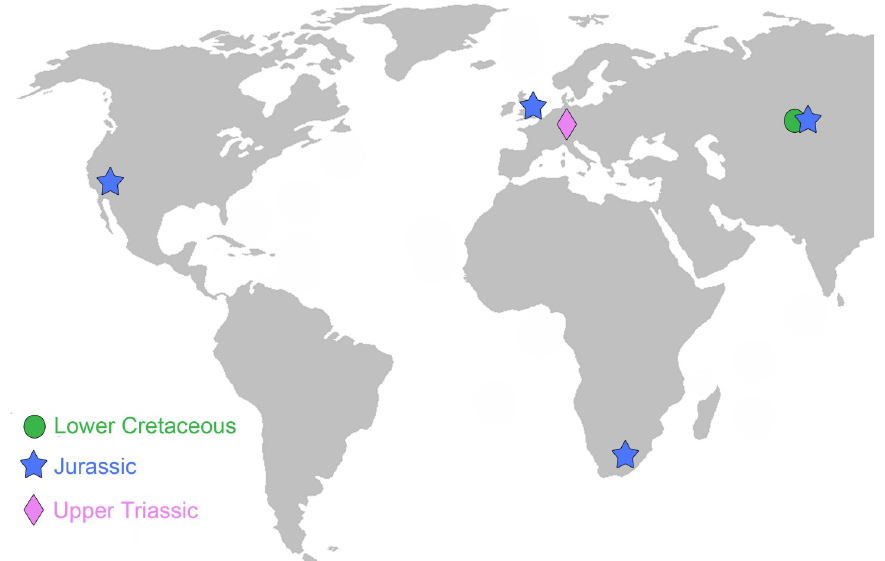
Fig 1. Approximate geographic locations and stratigraphic positions of the tritylodontid taxa analyzed in this paper. Map reprinted from Wikimedia Commons under a CC BY license, with permission from ‘E Pluribus Anthony’, original copyright 2006. The map is similar but not identical to the original map and is for illustrative purposes only.